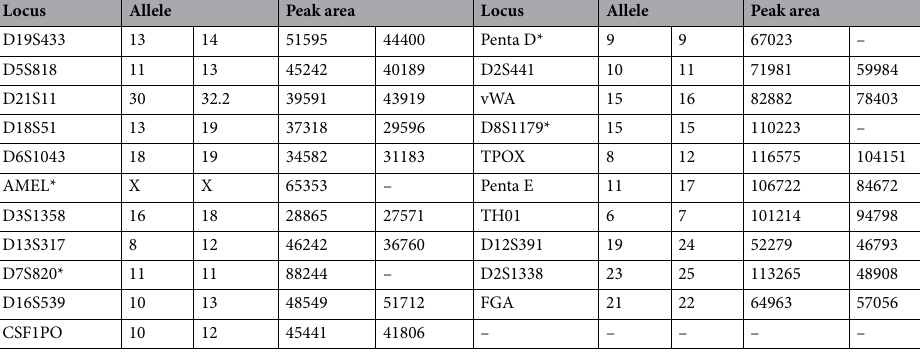
Table 2. Post gavage (0 min) STR analysis: loci, alleles and peak areas. Average peak area = (51595 + 44400 + 45242 + 40189 + 39591 + ⋯ + 64963 + 57056)/38 = 61580.26. *Represents